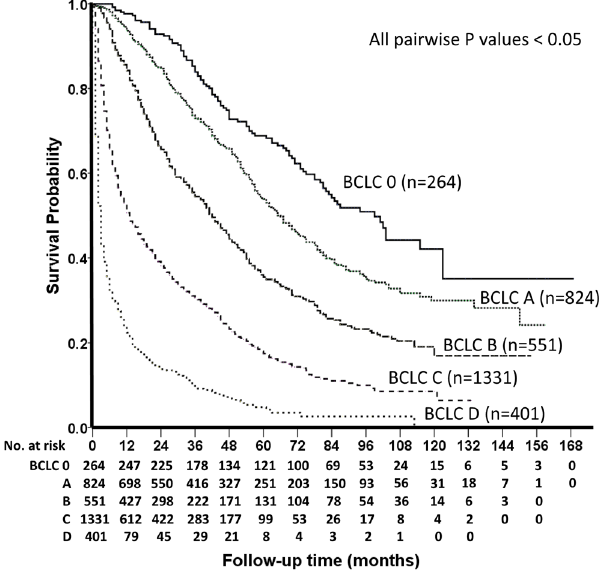
Figure 1. Survival distribution according to the BCLC system. The outcome of patients with early BCLC stage is significantly better than the survival of patients with advanced HCC. All p values for pairwise comparisons are ≤ 0.05.